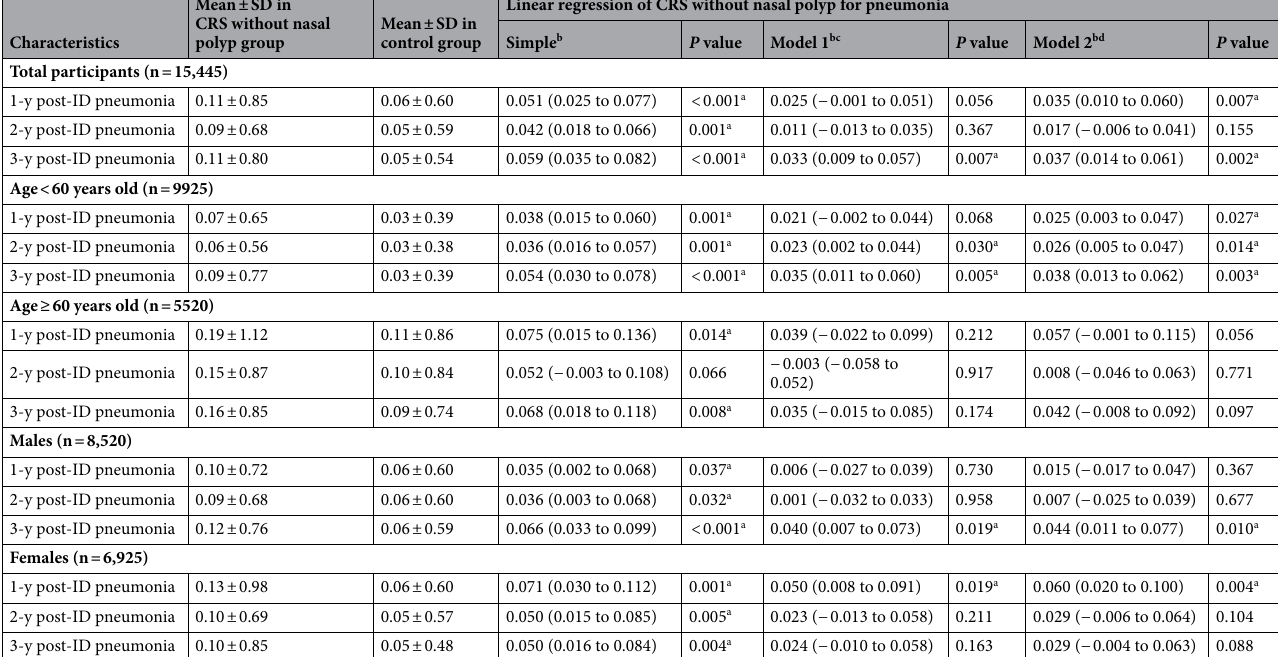
Table 4. Simple and multiple linear regression model (estimated value [95% confidence intervals]) for post index date of pneumonia (post-ID pneumonia) periods in chronic rhinosinusitis without nasal polyp compared to control group and subgroup analysis according to age and sex. CCI, Charlson comorbidity index; COPD, chronic obstructive pulmonary disease; DBP, diastolic blood pressure; CRS, chronic rhinosinusitis; 1-y pre-ID pneumonia, pneumonia history from the date of CRS treatment (index date) to the date before 1-year periods; Post-ID pneumonia, the number of pneumonia diagnosis from the index date to the date after